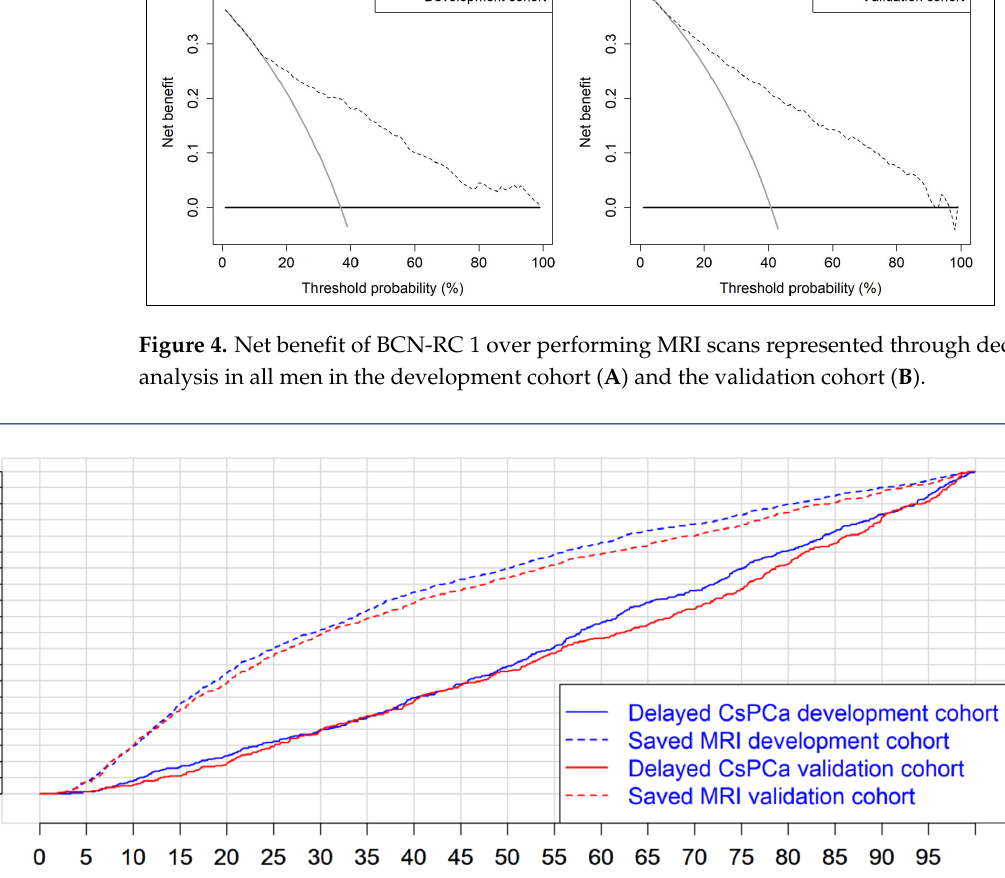
Table 3. Specificities of developed predictive model corresponding to sensitivities of 0.80, 0.85, 0.90, and 0.95 in the development and validation cohorts. Sensitivity